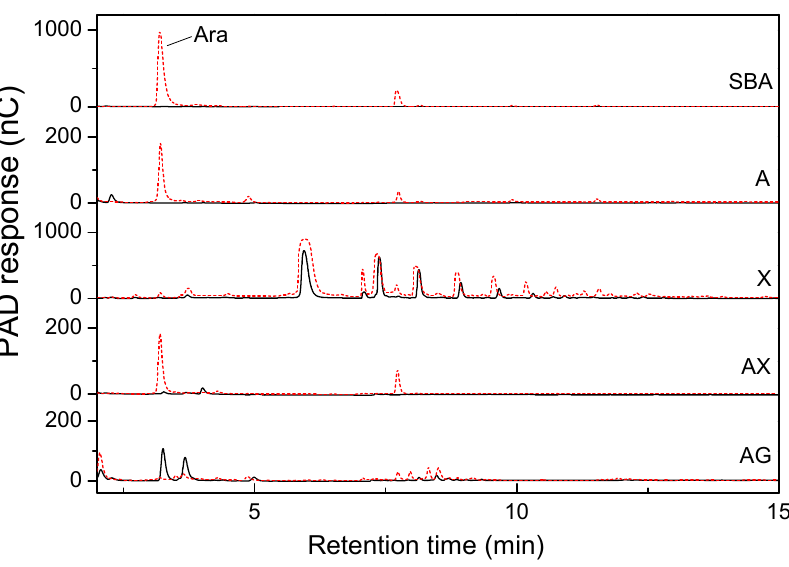
Figure 7. HPAEC analysis of the hydrolysis products of neutral arabinose-containing polysaccharides by Pp Abf51b. SBA, sugar beet arabinan; A, Linear-1, 5- α -arabinan; X, oat spelt xylan; AX, wheat arabinoxylan; AG, larch wood arabinogalactan. The black solid line represents the substrate and the red dashed line represents the hydrolysis product.